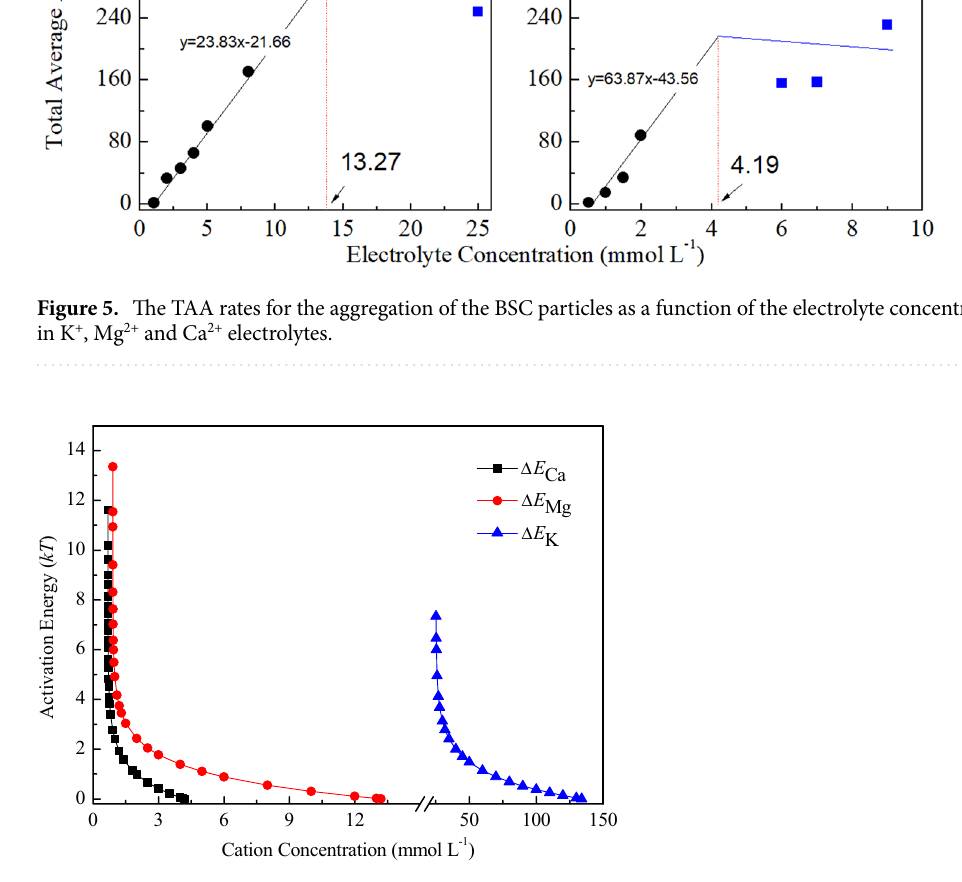
Figure 6. The activation energies ∆ E ( f 0 ) for the aggregation of the black soil colloid particles in K + , Ca 2+ and Mg 2+